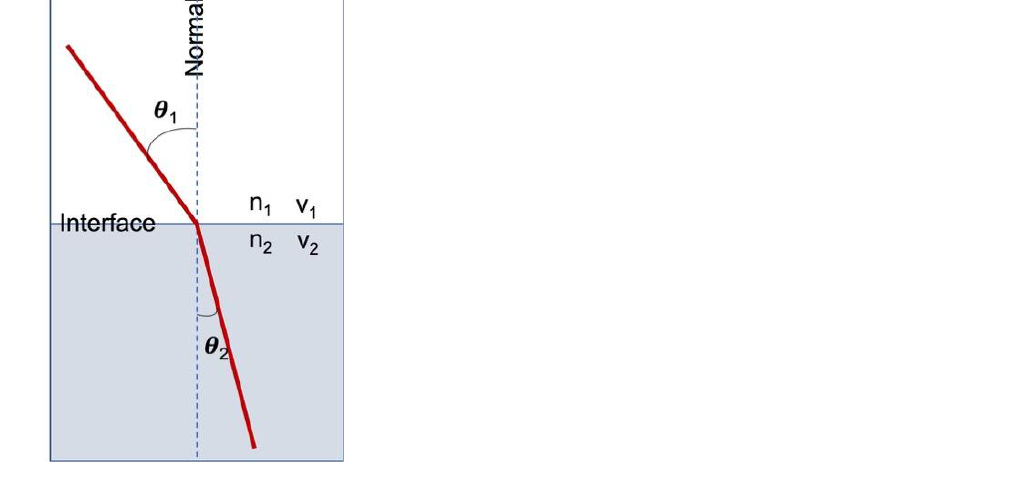
Figure 1. Refraction of light at the interface between two media of different refractive indices, with n 2 > n 1 . Since the velocity is lower in the second medium (v 2 < v 1 ), the angle of refraction θ 2 is less than the angle of incidence θ 1 .